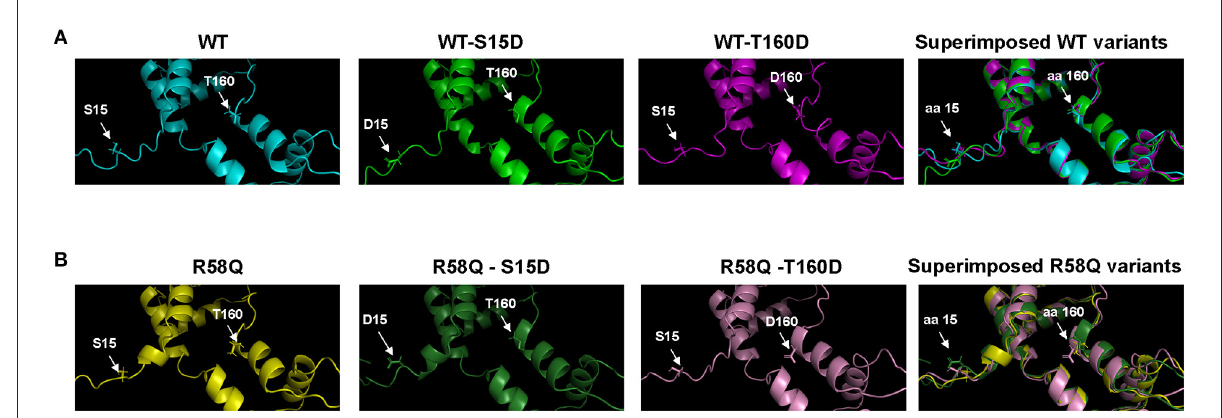
FIGURE6 The S15 and T160 phosphorylation sites are visualized as phosphomimetics S15D and T160D in the human cardiac RLC-WT (A) and RLC-R58Q (B) proteins. I-TASSER derived secondary structures of the human cardiac RLC were built using protein templates selected from the Protein Data Bank (PDB): 5tbyE, 3dtpE, 3jvtB, 3pn7E, 3j04B, 3i5iB, 2w4aB, 2bl0C, 6iihA, and 6k7yI. Note that mild intramolecular rearrangements in the vicinity of phosphorylation sites at amino acids (aa) 15 and 160 are visible in the superimposed structures of WT and R58Q proteins.